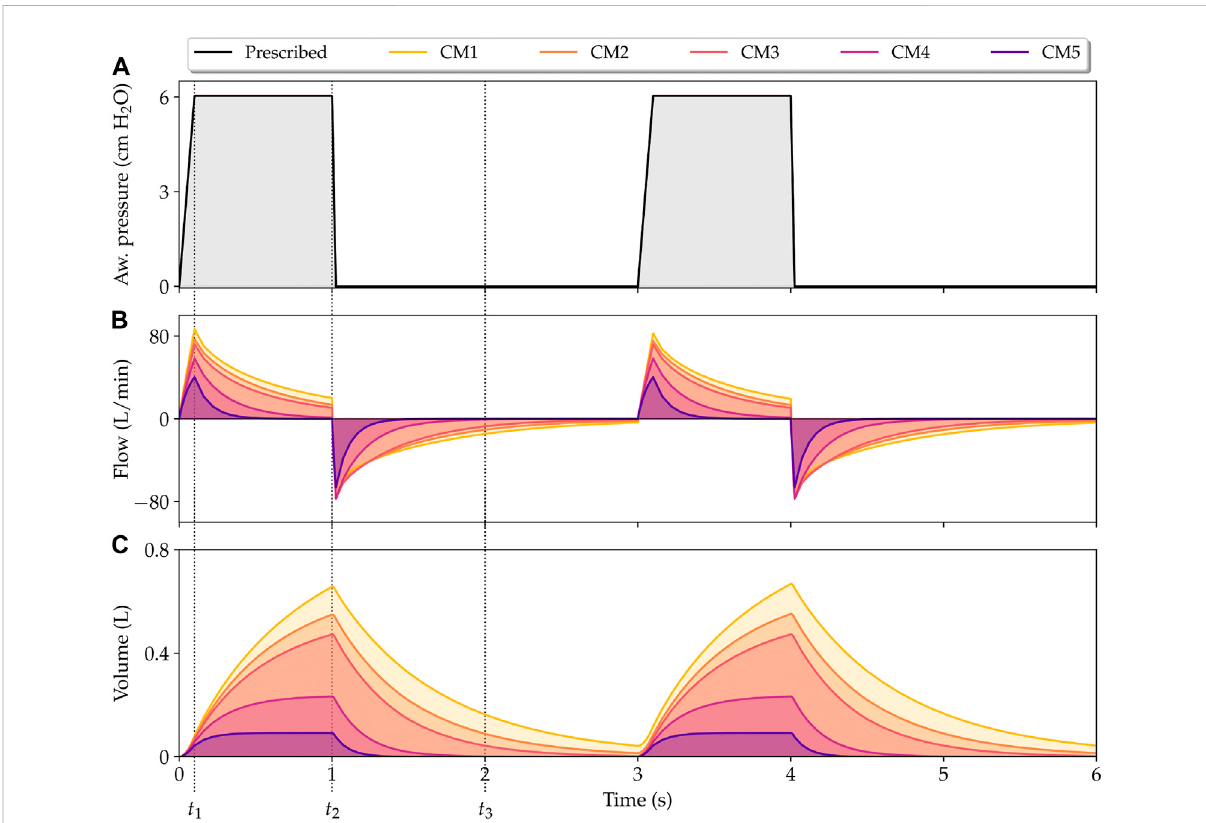
FIGURE 3 Simulation of lungs under pressure-controlled mechanical ventilation. Physiological signals that describe the time evolution of airway pressure (A) , fl ow (B) , andvolume (C) are shown for all constitutive modelsconsidered inthiswork. t 1 , t 2 , and t 3 represent thetime instants for peak fl ow, peak volume, and half expiratory time,